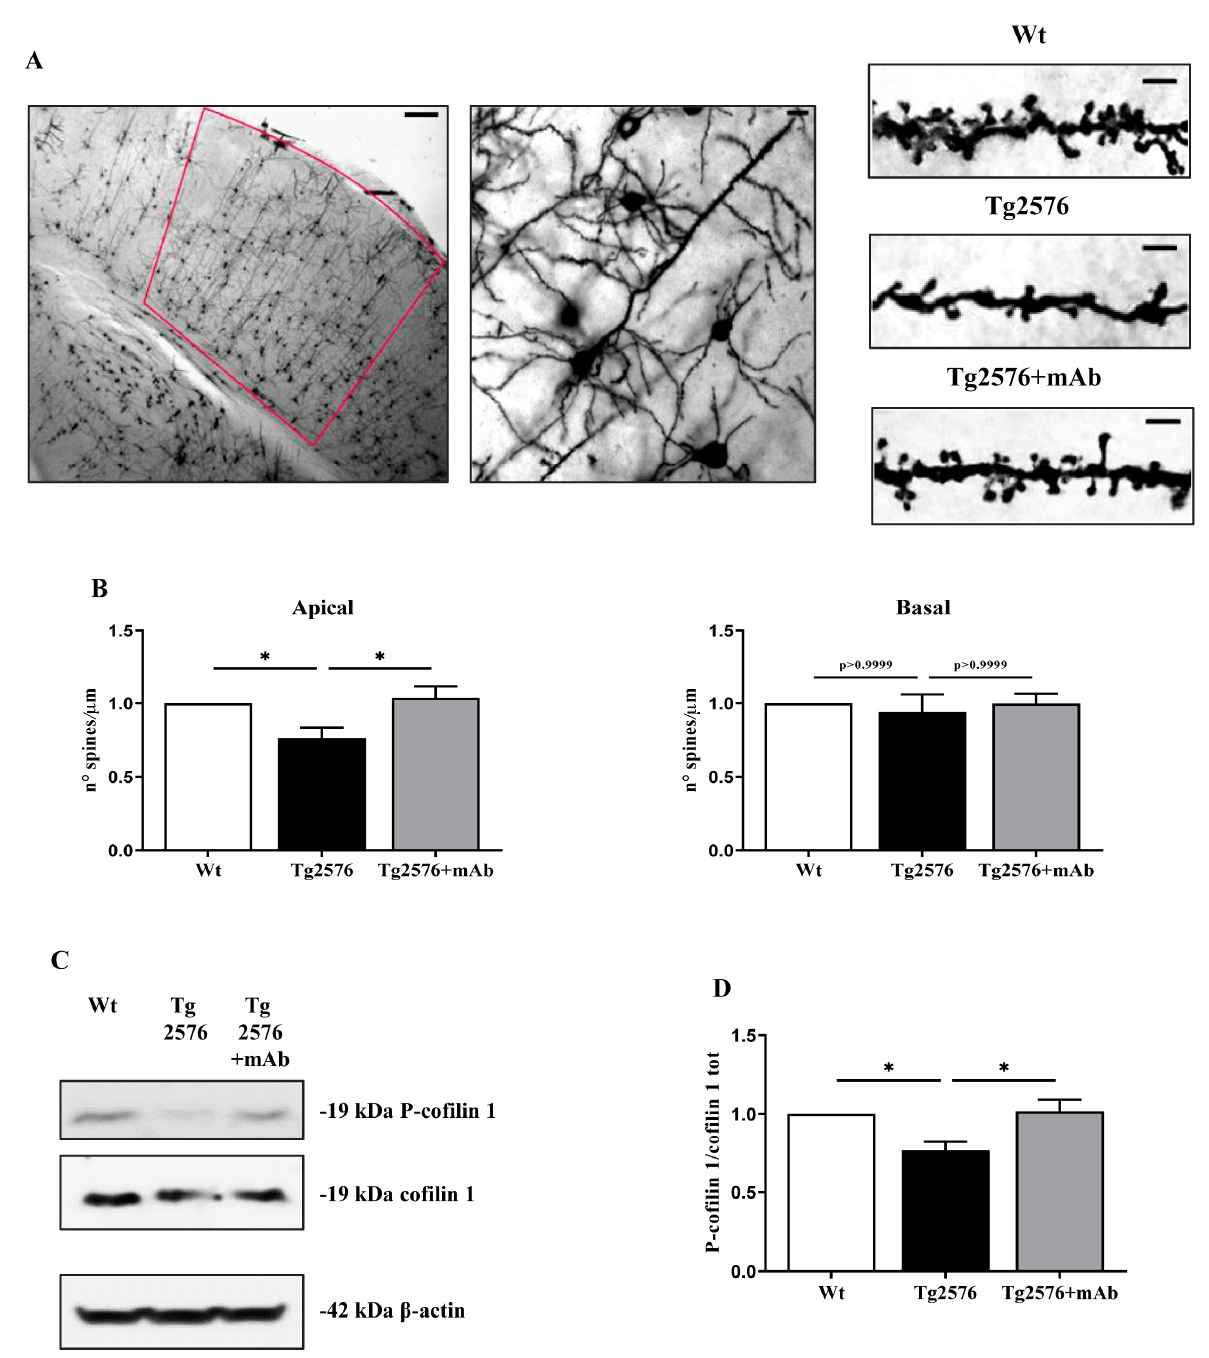
Figure 5. Treatment with 12A12mAb is protective against the dendritic spine density loss oc- curring in the primary visual cortex (V1) from Tg2576 AD mice in concomitance with deficits in their vision. ( A ) Representative micrographs of a coronal hemisection at the level of the primary visual cortex (V1) impregnated using the Golgi–Cox method showing dendritic